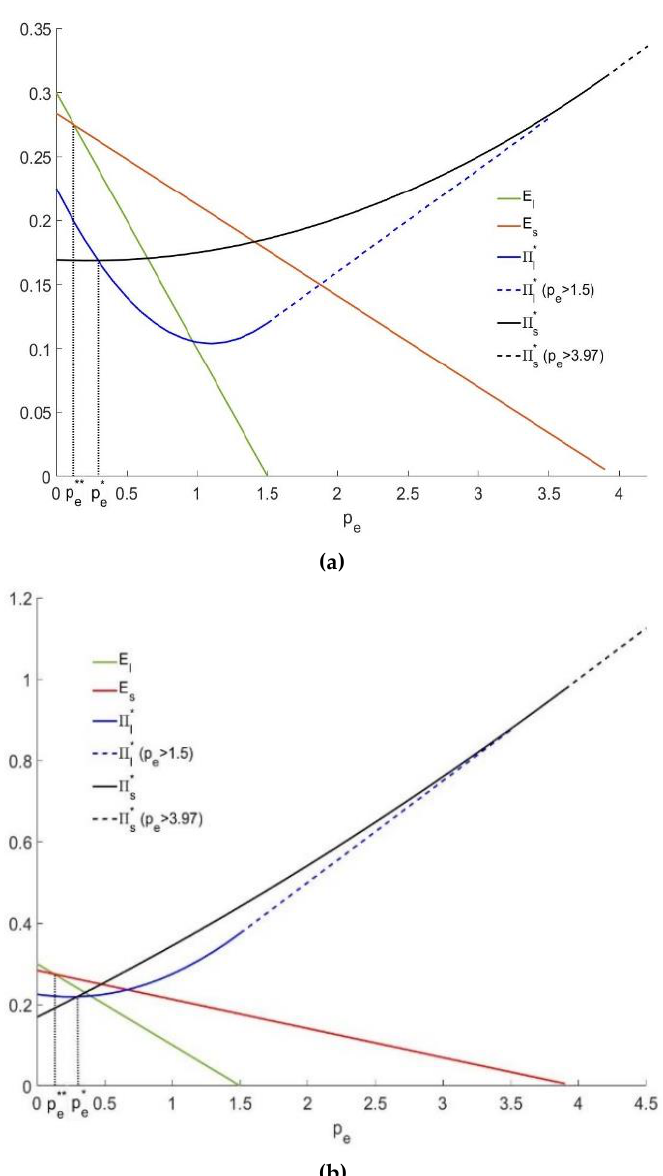
Figure 8. The effect of p e on the optimal profit and total carbon emissions. ( a ) when Q 5 = 0.08; ( b ) when Q 2 = 0.25.